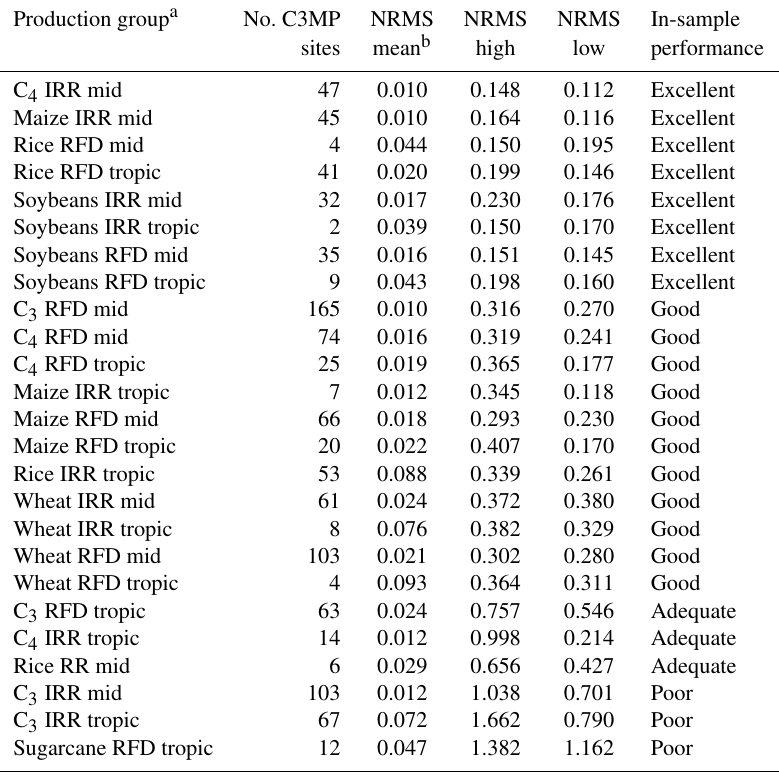
Table 1. Persephone v1.0 response function performance for all production groups for cubic µ CTW (Eq. 4), quadratic σ CTW (Eq. 6). Production group a